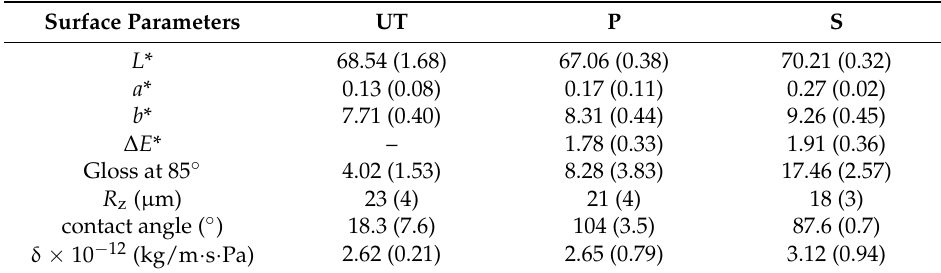
Table 2. Surface properties of concrete: untreated (UT), treated with a permanent (P) and a sacrificial anti-graffiti coating (S). Standard deviation in parentheses, n =